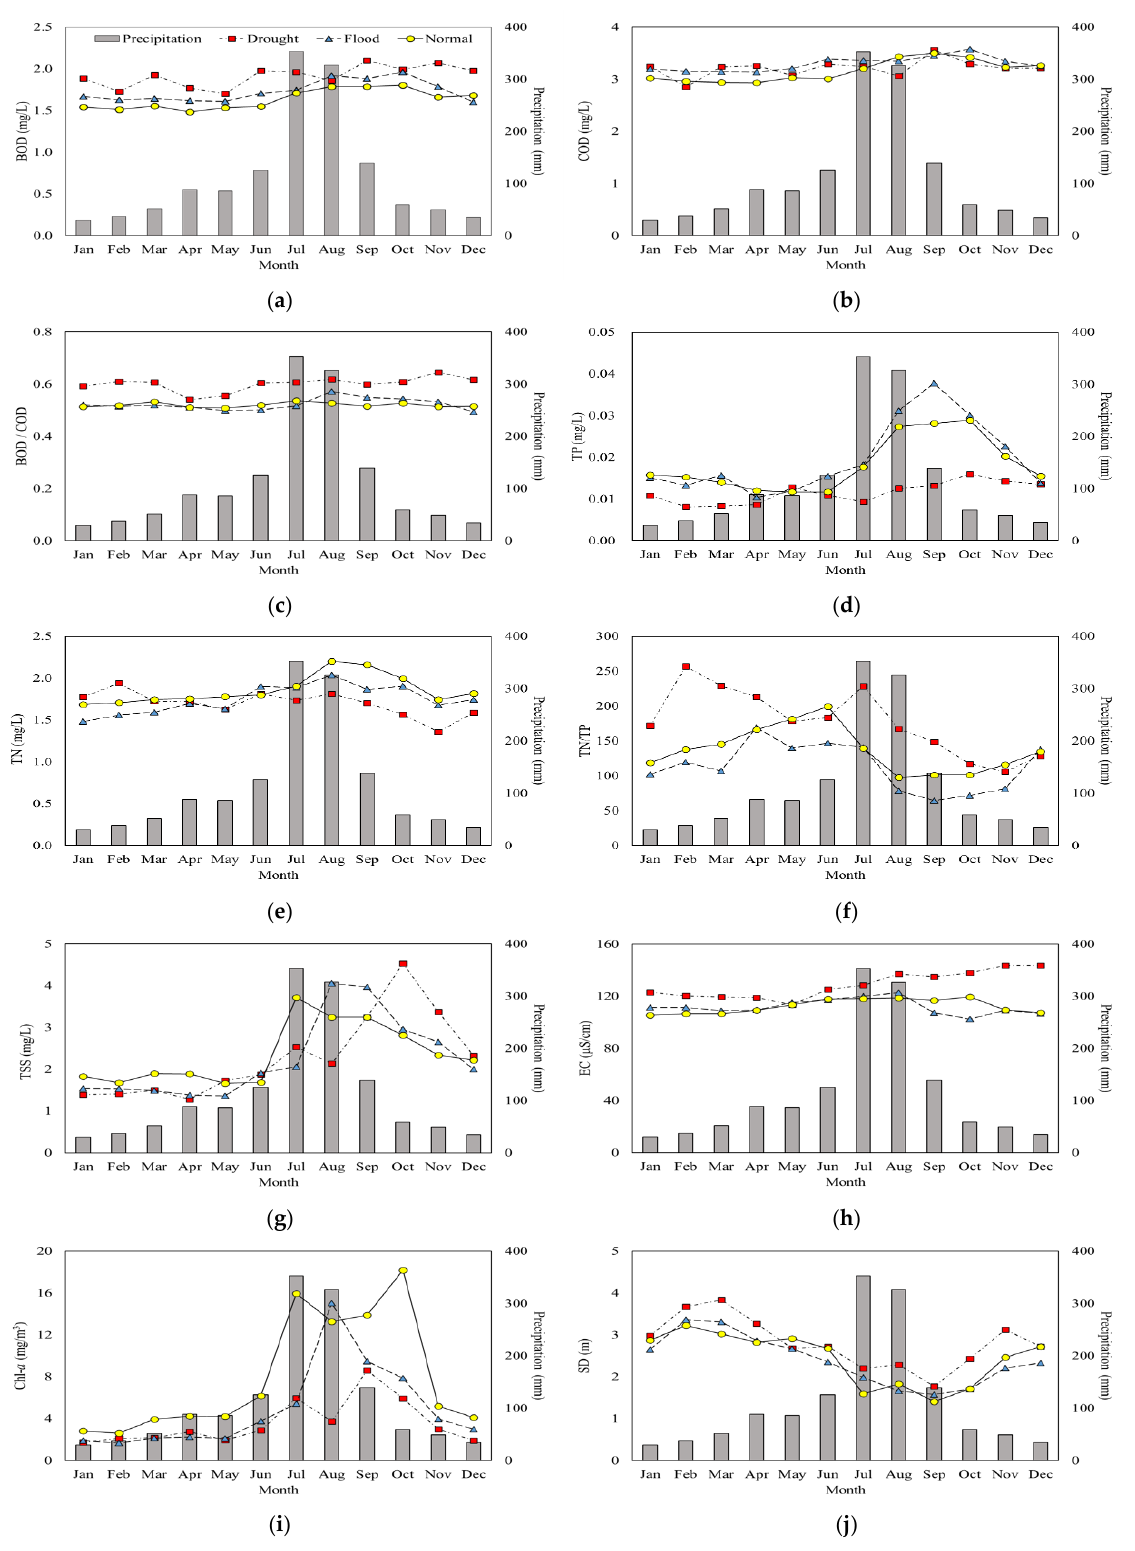
Figure 4. Monthly variation of water quality parameters in the drought, flood, and normal years: ( a ) BOD, ( b ) COD, ( c ) BOD/COD, ( d ) TP, ( e ) TN, ( f ) TN/TP, ( g ) TSS, ( h ) EC, ( i ) Chl- a , and ( j ) SD. Bar graphs in the background display the average monthly precipitation over the 20-year study